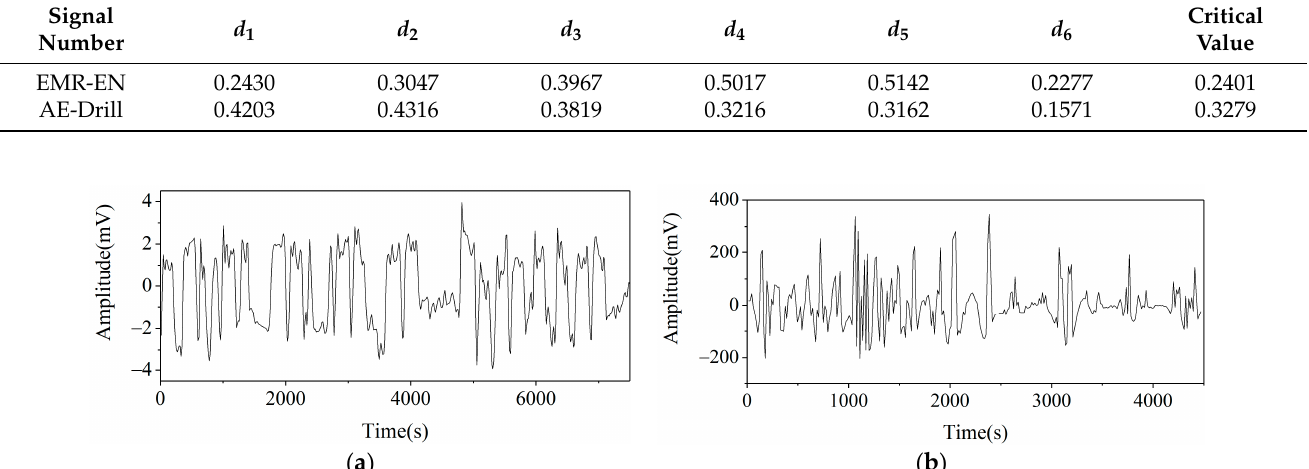
Table 1. Similarity and critical value of the decomposed signals and the original signal.